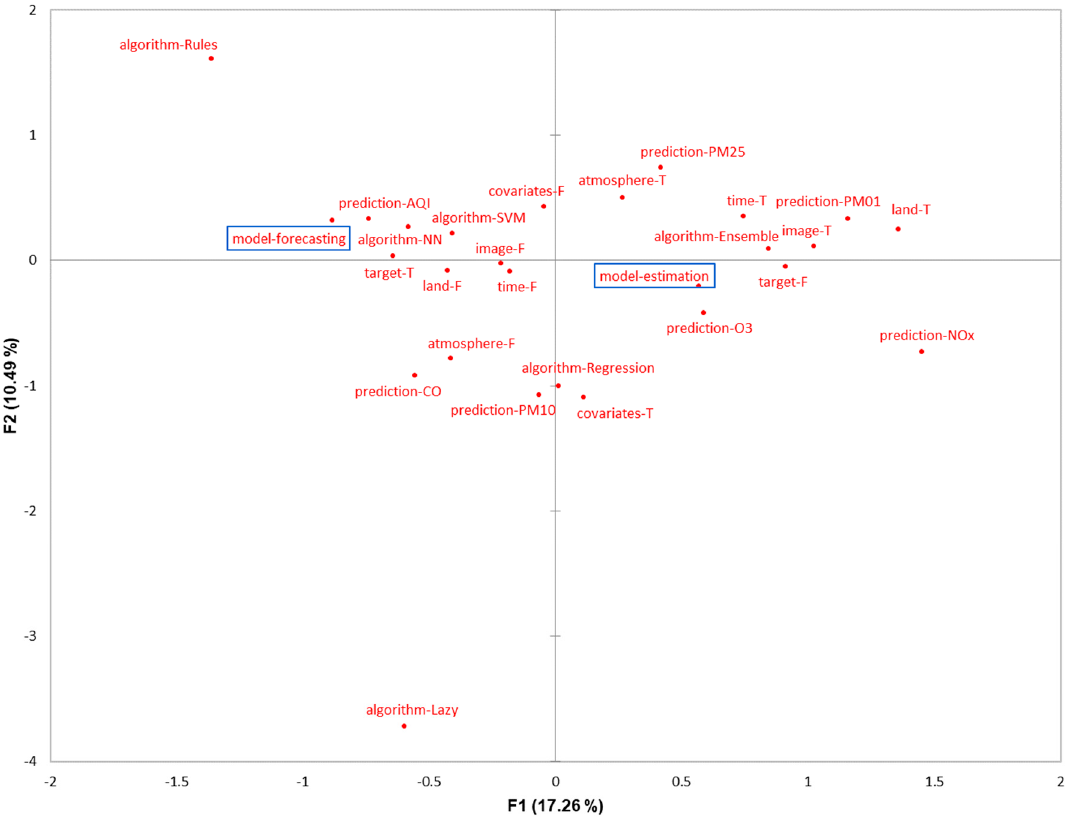
Figure 5. MCA representation of the point cloud of the categories that characterize the selected papers. The studies are described from nine variables (J) and 27 categories (K). Variable 1 is the type of modelling and has two categories: Estimation (model-estimation) and forecast (model-forecasting). Variable 2 is the type of algorithm and has six categories: Ensemble Learning (algorithm-Ensemble), Neural Network (algorithm-NN), Support Vector Machine (algorithm-SVM), Multiple Regression (algorithm-Regression), Decision Rules (algorithm-Rules), and Lazy methods (algorithm-Lazy). Variable 3 is the predicted parameter and has seven categories: Air Quality Index (prediction-AQI), PM 10 (prediction-PM10), PM 2.5 (prediction-PM25), nanoparticles (prediction-PM01), carbon monoxide (prediction-CO), nitrogen oxides (prediction-NOx), and ozone (prediction-O3). Variable 4 is the feature target and has two categories: Used (target-T) and not used (target-F). Variable 5 is the feature pollutant covariates and has two categories: Used (covariates-T) and not used (covariates-F). Variable 6 is the feature atmospheric parameters and has two categories: Used (atmosphere-T) and not used (atmosphere-F). Variable 7 is the feature land use and has two categories: Used (land-T) and not used (land-F). Variable 8 is the feature time and has two categories: Used (time-T) and not used (time-F). Variable 9 is the feature image processing and has two categories: Used (image-T) and not used